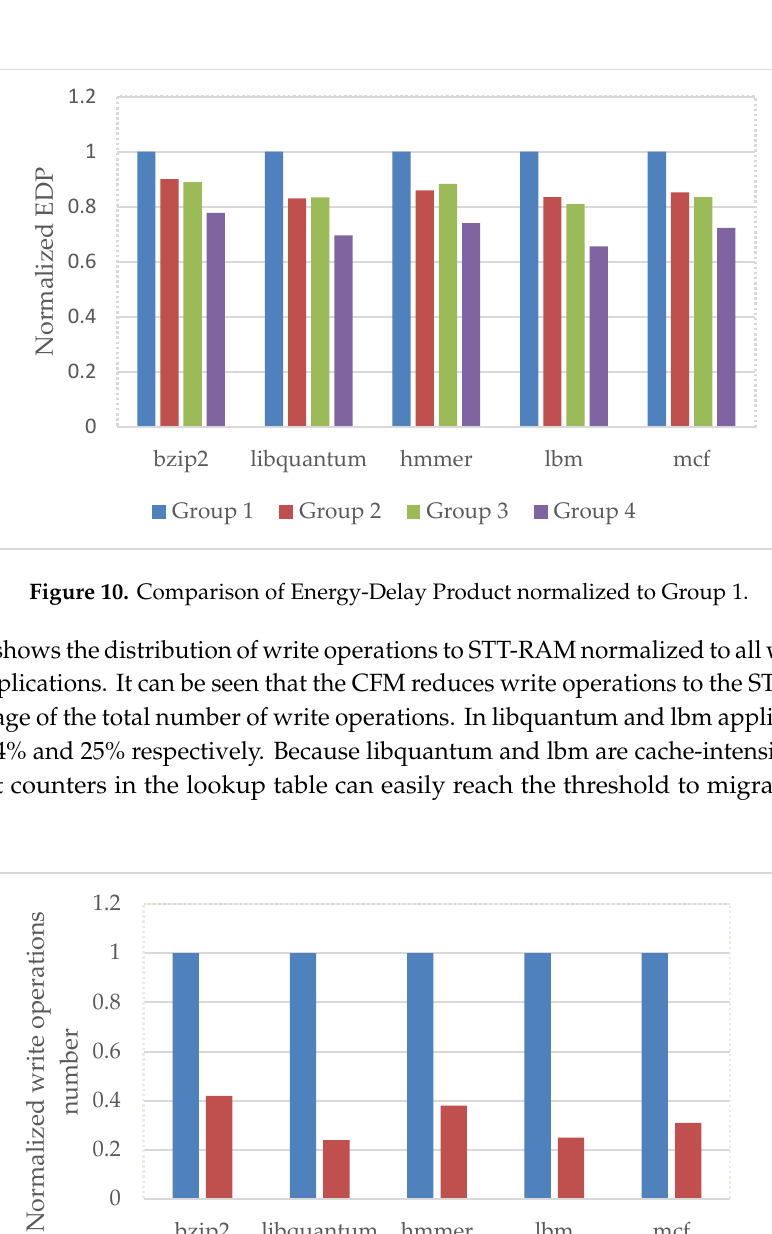
Figure 9. Comparison of System Delay normalized to Group 1.